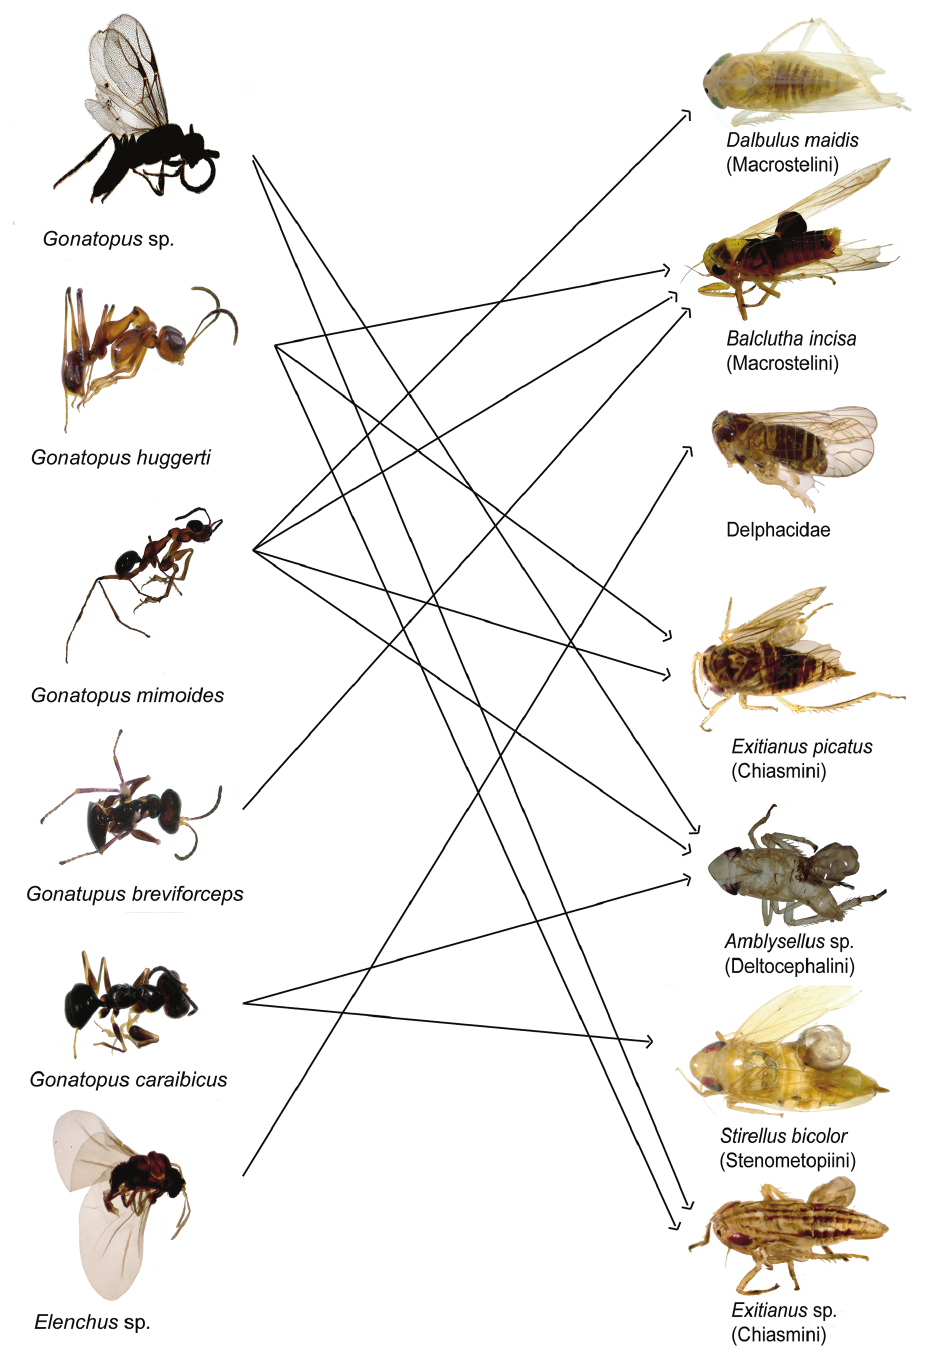
Figure 1. Total of parasitoid-host interactions found on the edges of maize agroecosystem in the winter seasons of 2014 and 2015. Name in parenthesis show the name of the host